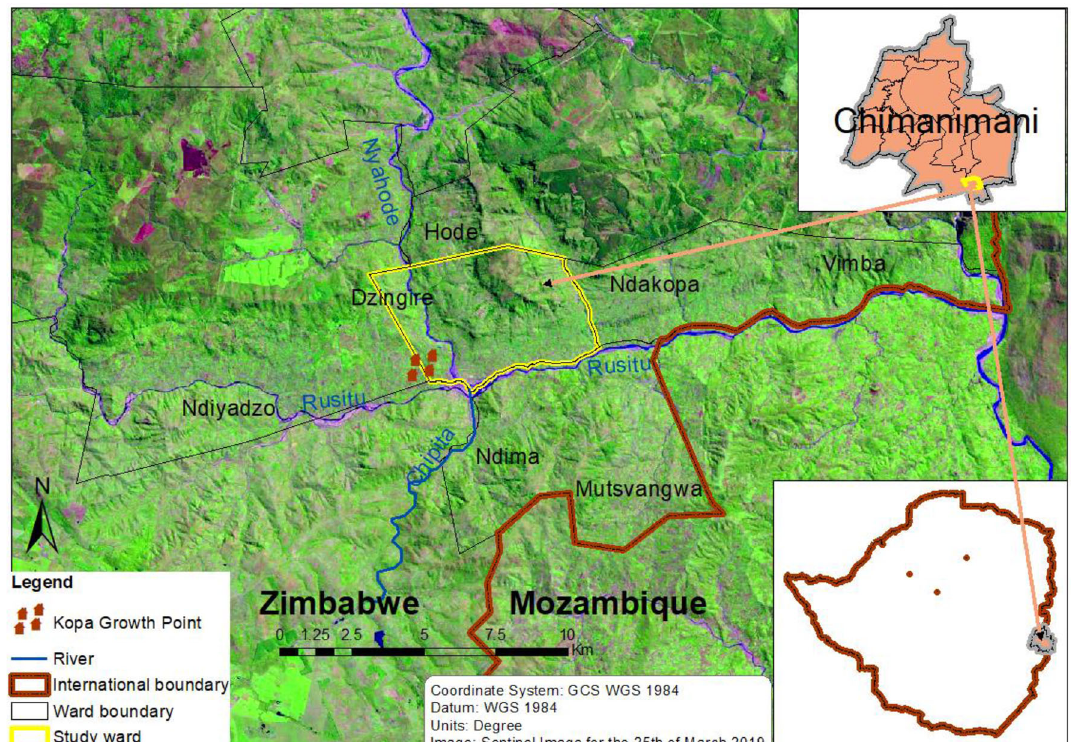
Fig. 1 Location of the study area in Chimanimani District,